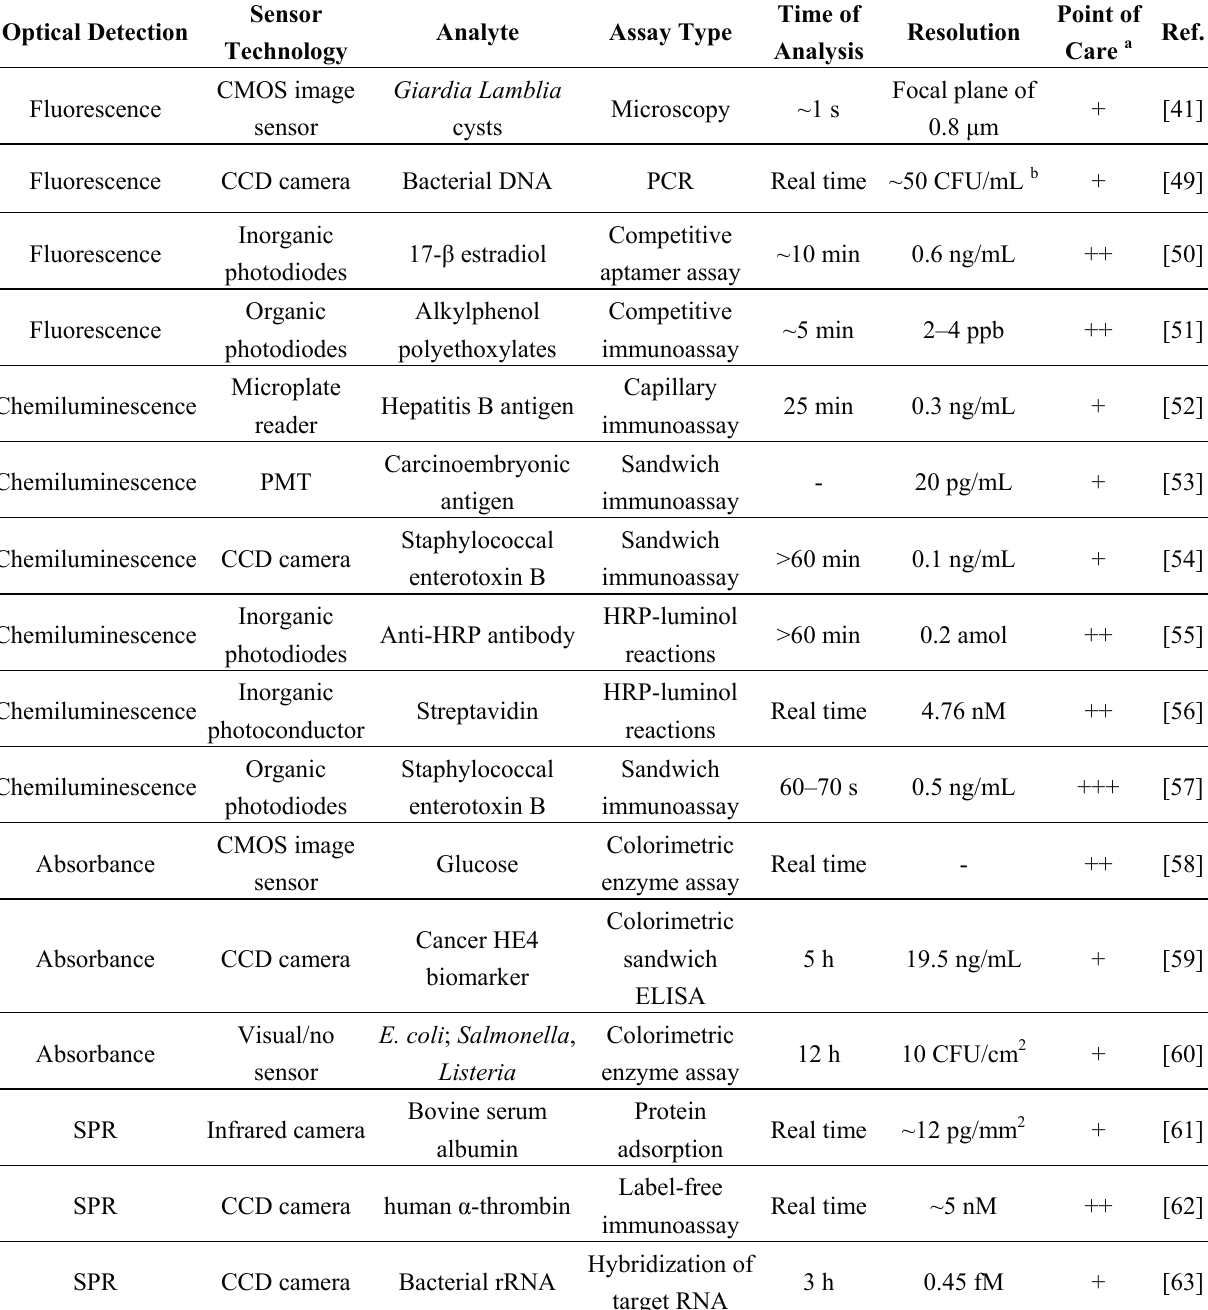
Table 2. Up-to-date summary on opto-microfluidic detection